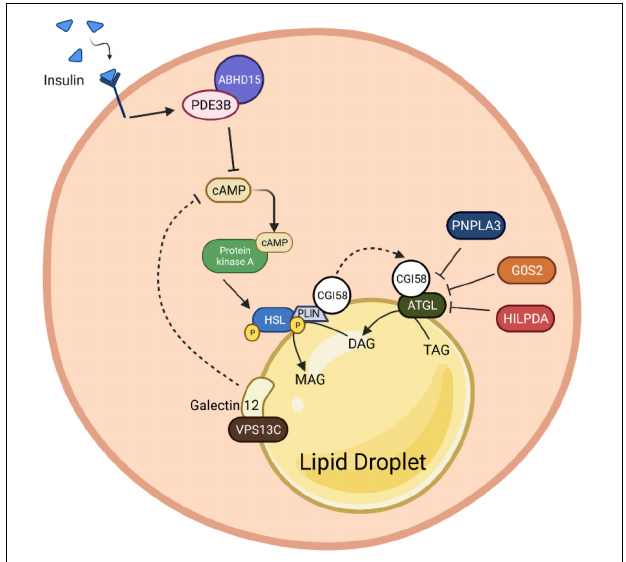
FIGURE 4 | Protein-protein interaction roles in adipocyte lipolysis. Insulin binding induces stabilization of PDE3B with ABHD15. This molecular complex promotes cAMP degradation, which consequently inhibits the HSL phosphorylation upon PKA inactivation. Besides HSL, PLIN1 is also directly regulated by the PKA. The stimulation of PLIN1 mediates CGI58 release from the PLIN1 and HSL complex to bind with ATGL and induce its catalytic activity. Nevertheless, the complex of CGI58 and HSL can be suppressed by the presence of binding inhibitors, G0S2, HILPDA and PNPLA3. Presumably, Galectin12, a protein that localizes on lipid droplets, and its coactivator, VPSC13, can alter the cAMP production by inhibiting the PDE recruitment function, which in the end contributes to lipolysis abolition. PDE3B, phosphodiesterase 3B; cAMP, cyclic adenosine monophosphate; AMPK, AMP-activated protein kinase; HSL, hormone-sensitive lipase; PLIN1, perilipin 1; PKA, protein kinase A; CGI-58, comparative gene identification 58; ATGL, adipose triglyceride lipase; G0S2, G0/S2 switch protein 2; HILPDA, hypoxia-induced lipid droplet-associated protein; PNPLA3, patatin-like phospholipase domain-containing protein 3; VPSC13, vacuolar protein sorting